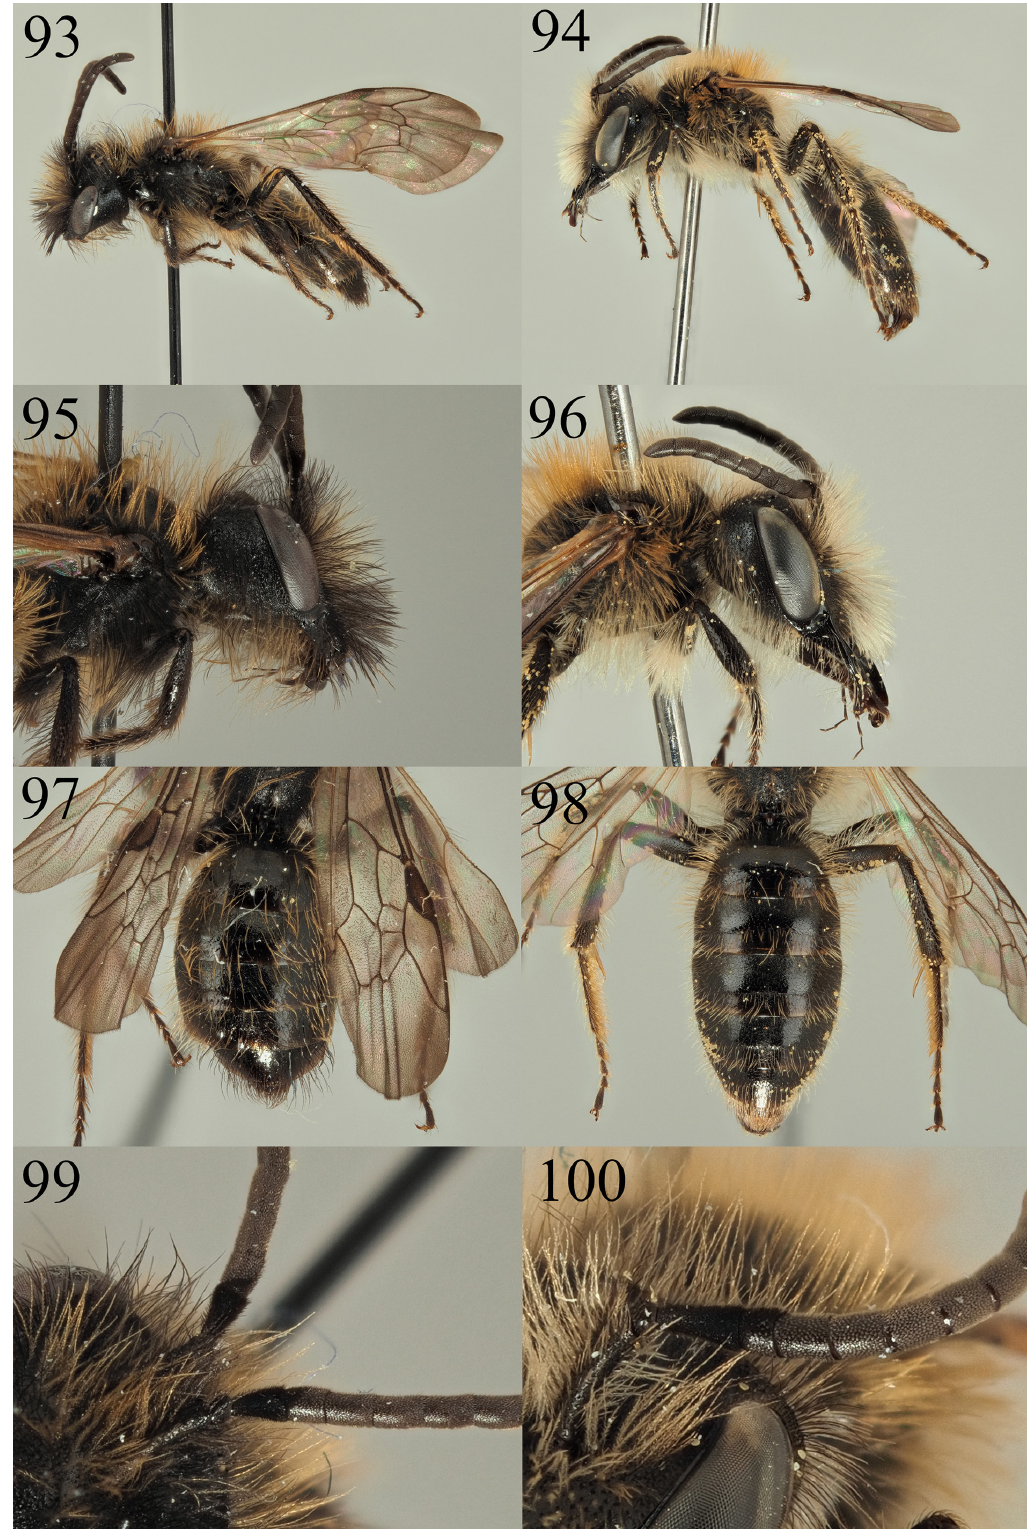
Figs 93–100. 93, 95, 97, 99. Andrena impressa Warncke, 1967 stat. nov. (TJWC). 93 . Male profile. 95 . Male gena. 97 . Male terga. 99 . Male antennae. — 94, 96, 98, 100 . Andrena angustior (Kirby,